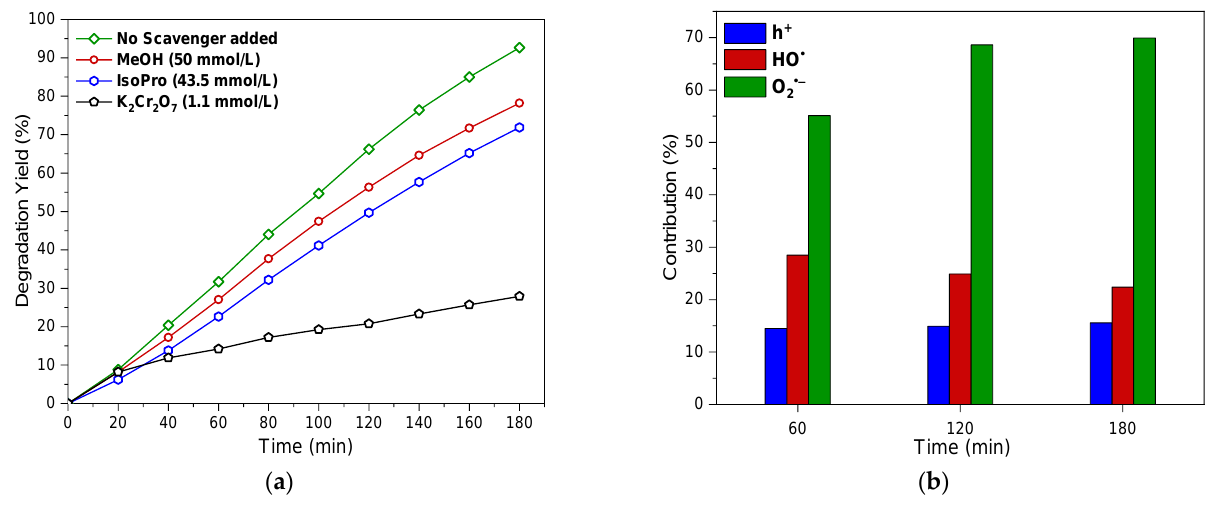
Figure 14. ( a ) Effect of additives in the degradation of 10 ppm of BPB and ( b ) Contribution of various active species in the photodegradation (500 mL of BPB solution, natural pH, under UV irradiation). The amount of radicals in the system involved in the dye degradation can differ significantly due to electron-hole recombination and recombination reactions of radical species [24].